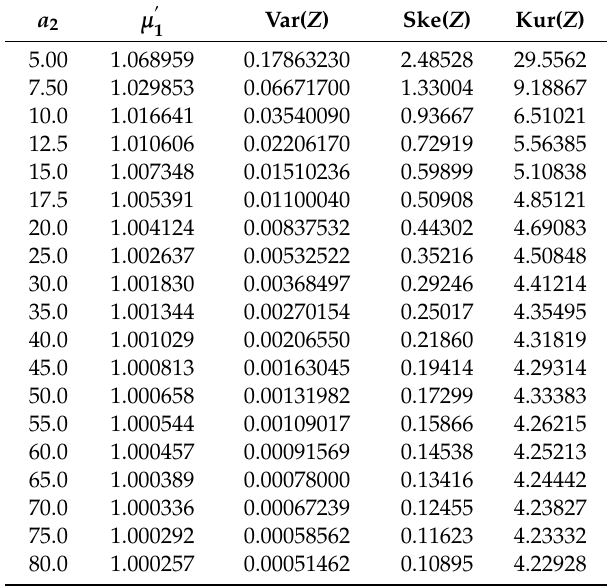
, Var( Z ), Ske( Z ), Kur( Z ) for the RG-LL 1